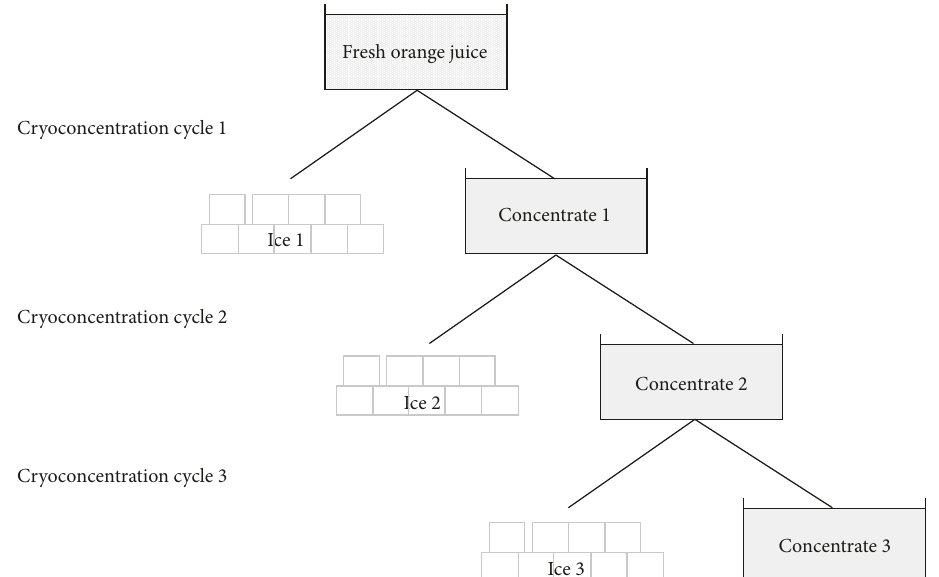
Figure 1: General experimental protocol. Fresh orange juice was frozen and then the sample was transferred to a centrifuge to force the separation of concentrate with solutes from the frozen solution in 3